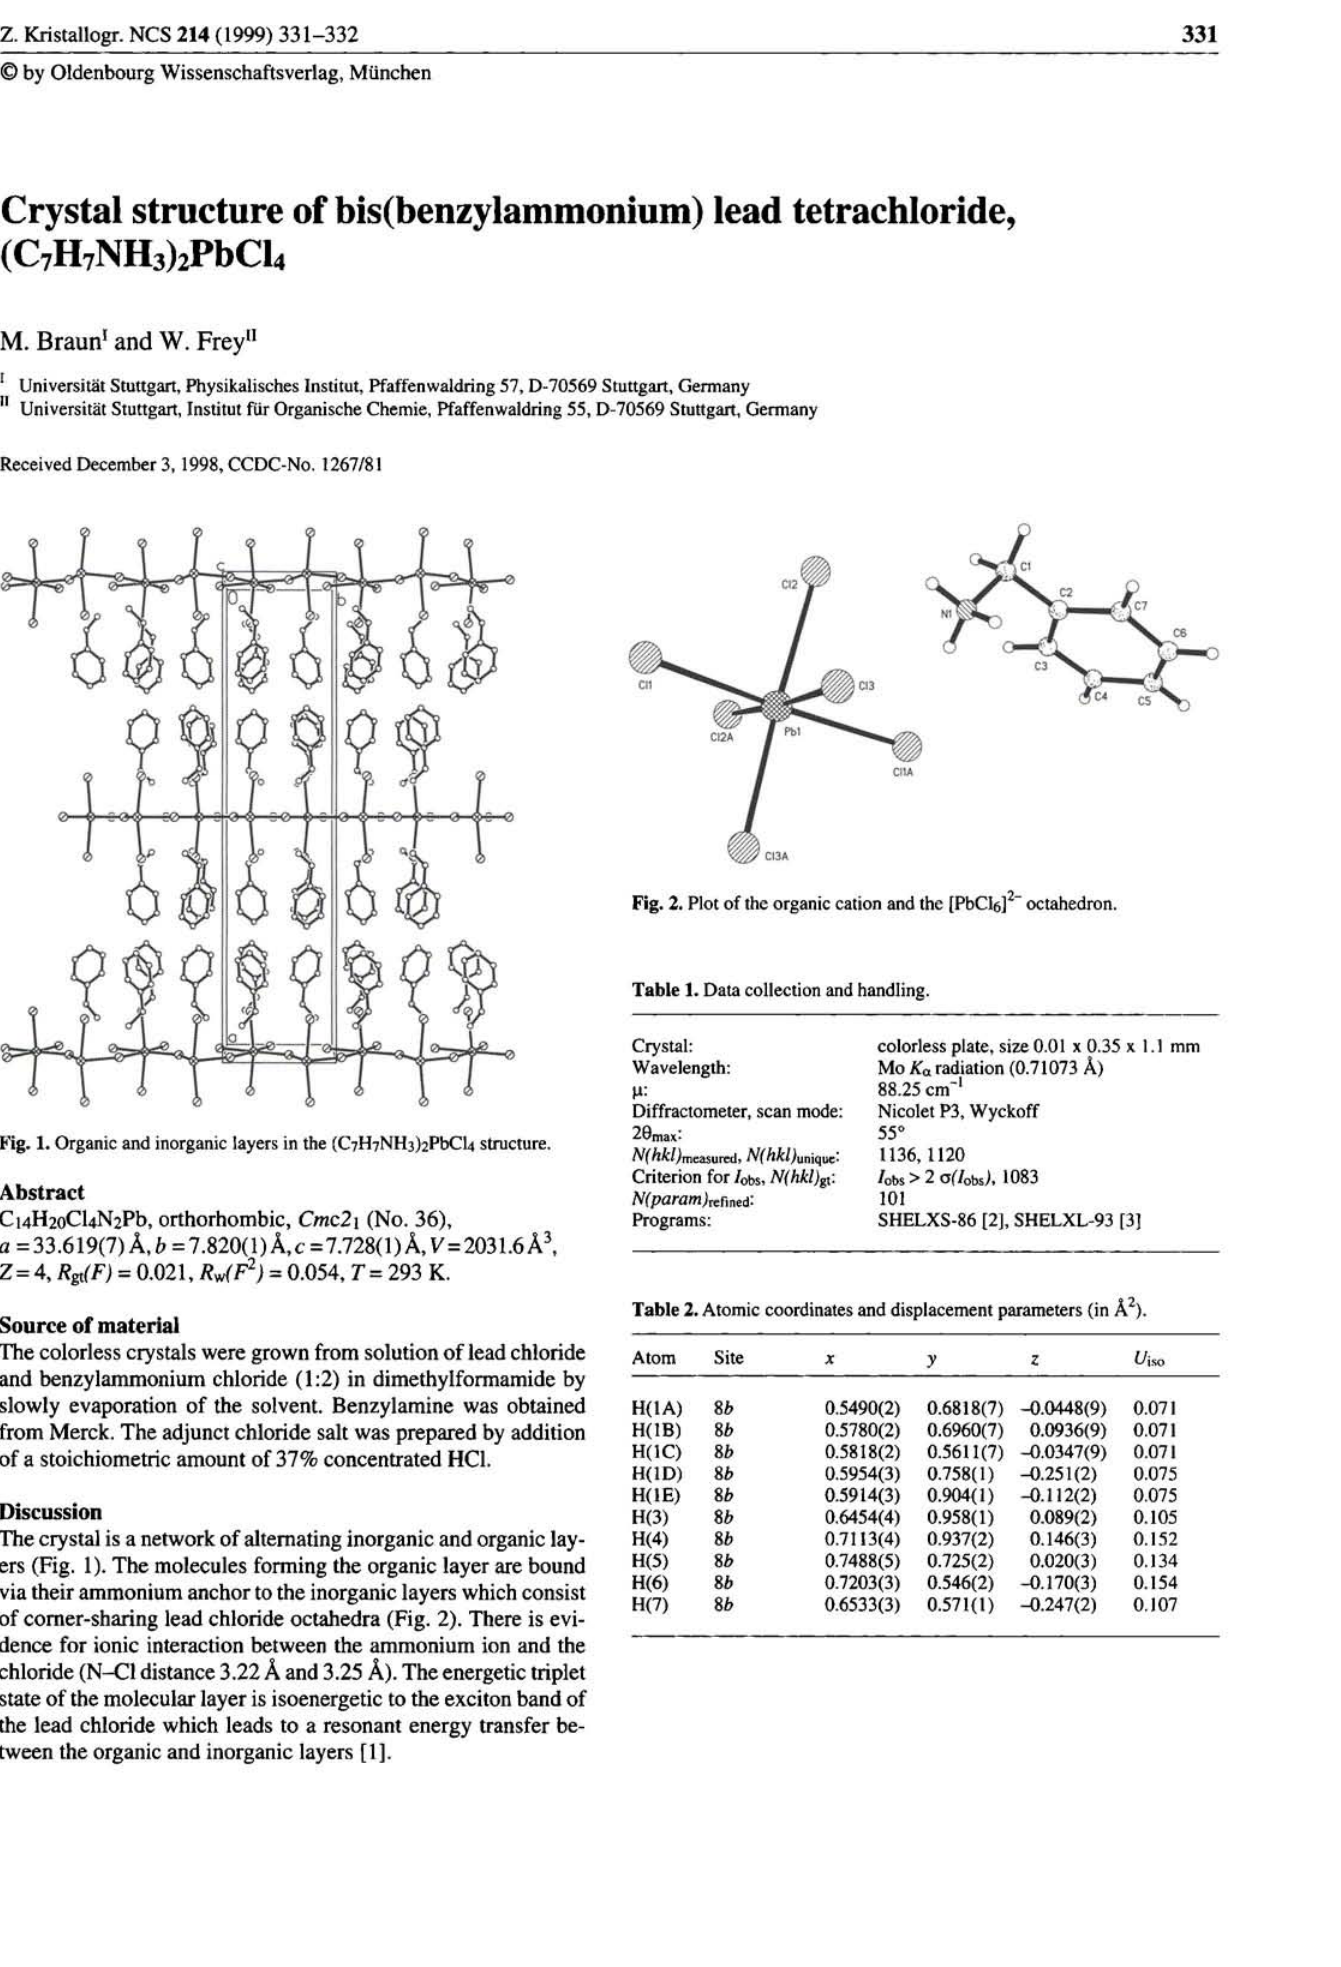
Fig. 2. Plot of the organic cation and the [PbClö] 2 octahedron.